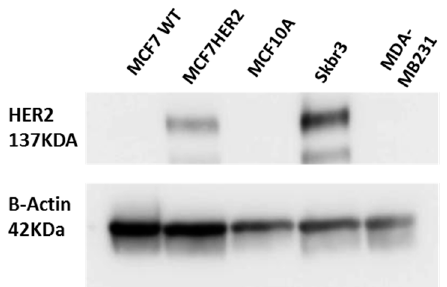
Figure 1. Validation of HER2 status in HER2 stably transfected MCF7 cells (termed MCF7HER2). Immunoblot analysis of HER2 expression in MCF7, MCF7HER2 and MCF10A cells. SKBR3 cells are used as a positive control and MDA-MB231 cell line as a negative control for HER2 expression. Presented immunoblots show a representative of 3 independent experiments.